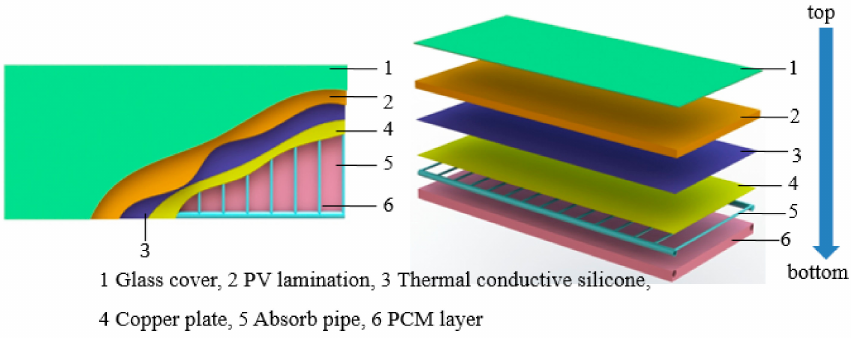
Figure 3. Schematic of a PV / T-PCM